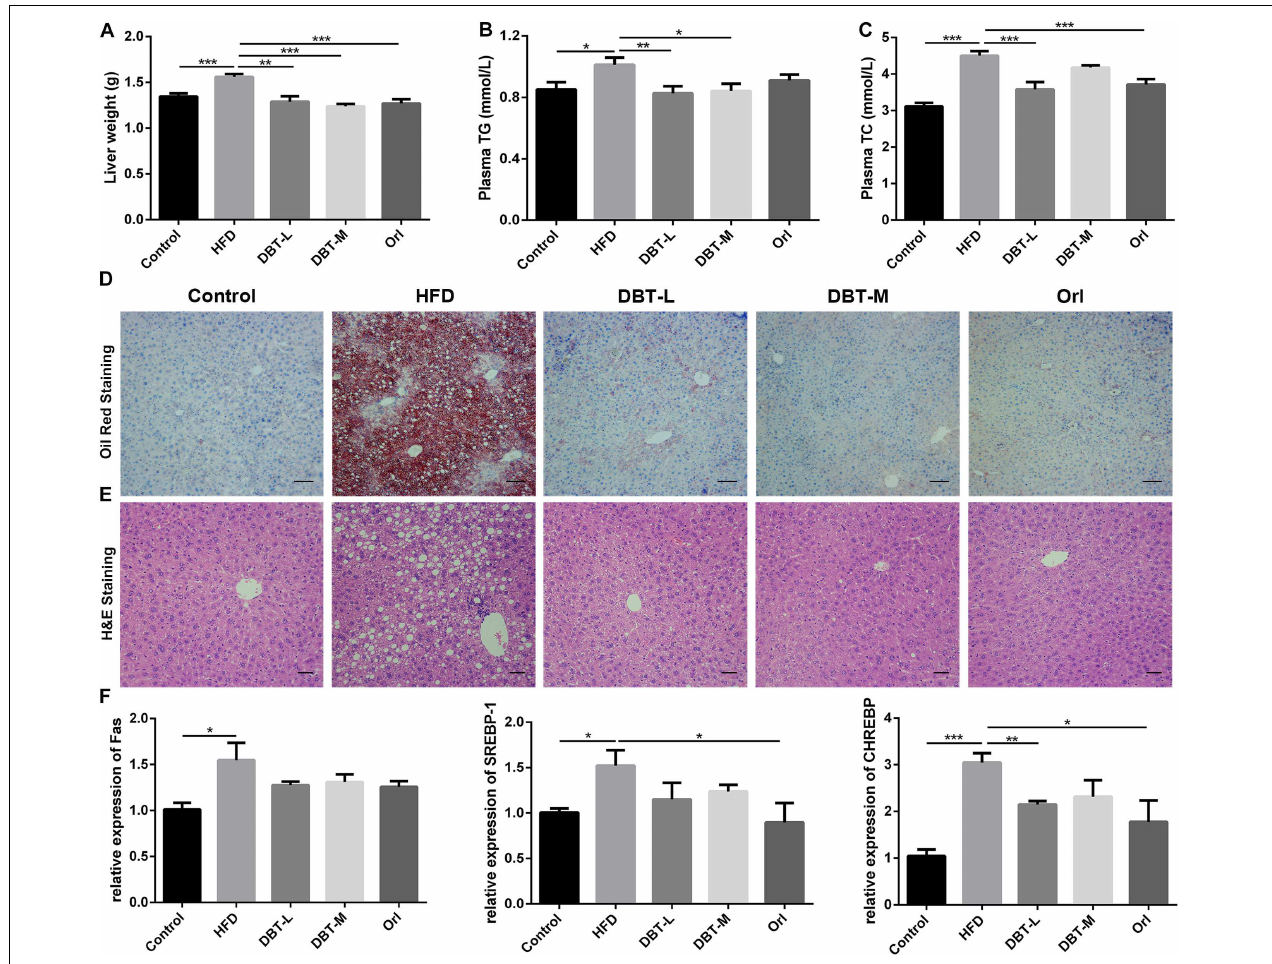
FIGURE 2 | DBT decreases liver lipid accumulation. (A) Liver weight; (B) Serum TG; (C) Serum TC; (D) Oil Red staining of liver, scale bar: 50 µ m; (E) Haematoxylin and eosin staining of liver, scale bar: 20 µ m; (F) qPCR assays of the liver mRNA levels of Fas, SREBP-1, CHREBP. Results are presented as mean ± SEM ( n = 7). ∗ p < 0.05, ∗∗ p < 0.01, ∗∗∗ p < 0.001 compare with HFD